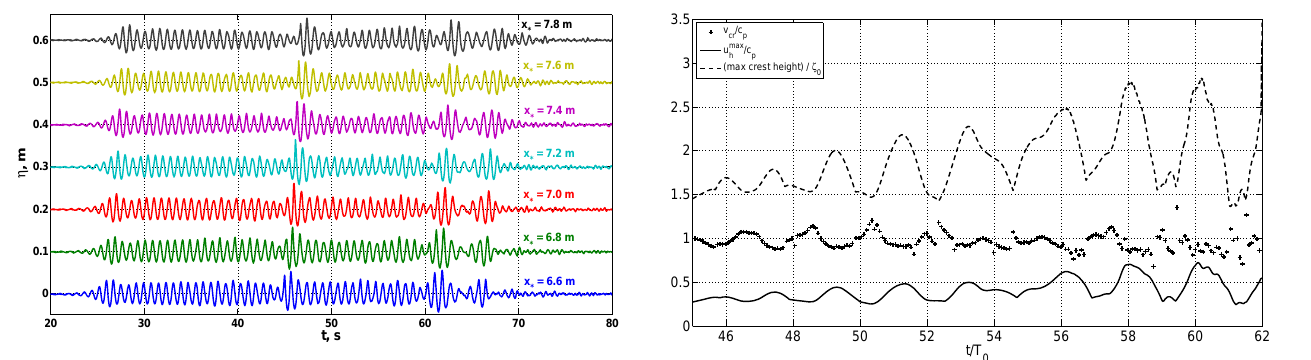
Figure 9. The computed temporal variation of the maximum crest heights, of the velocities of the steepest crests ( v cr ), and of maxi- mum horizontal fluid velocity ( u max ). h